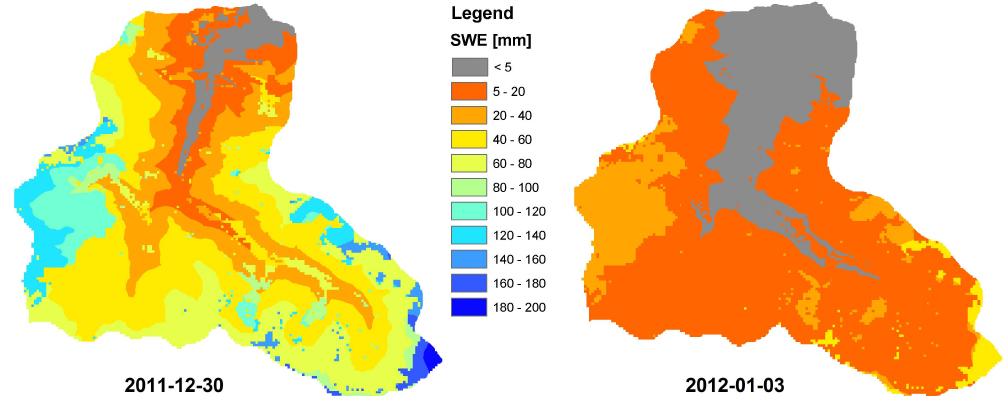
Fig. 7. SWE distribution in the Brugga catchment based on the snow depths derived from 19 camera locations and a simple linear regression model for forested and open areas before and after a rain-on-snow flood event on 2 January 2012.